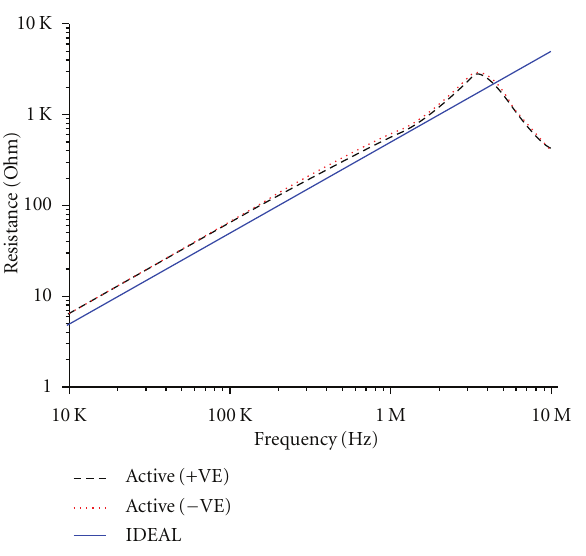
Figure 9: Variation of impedance with I b 1 .